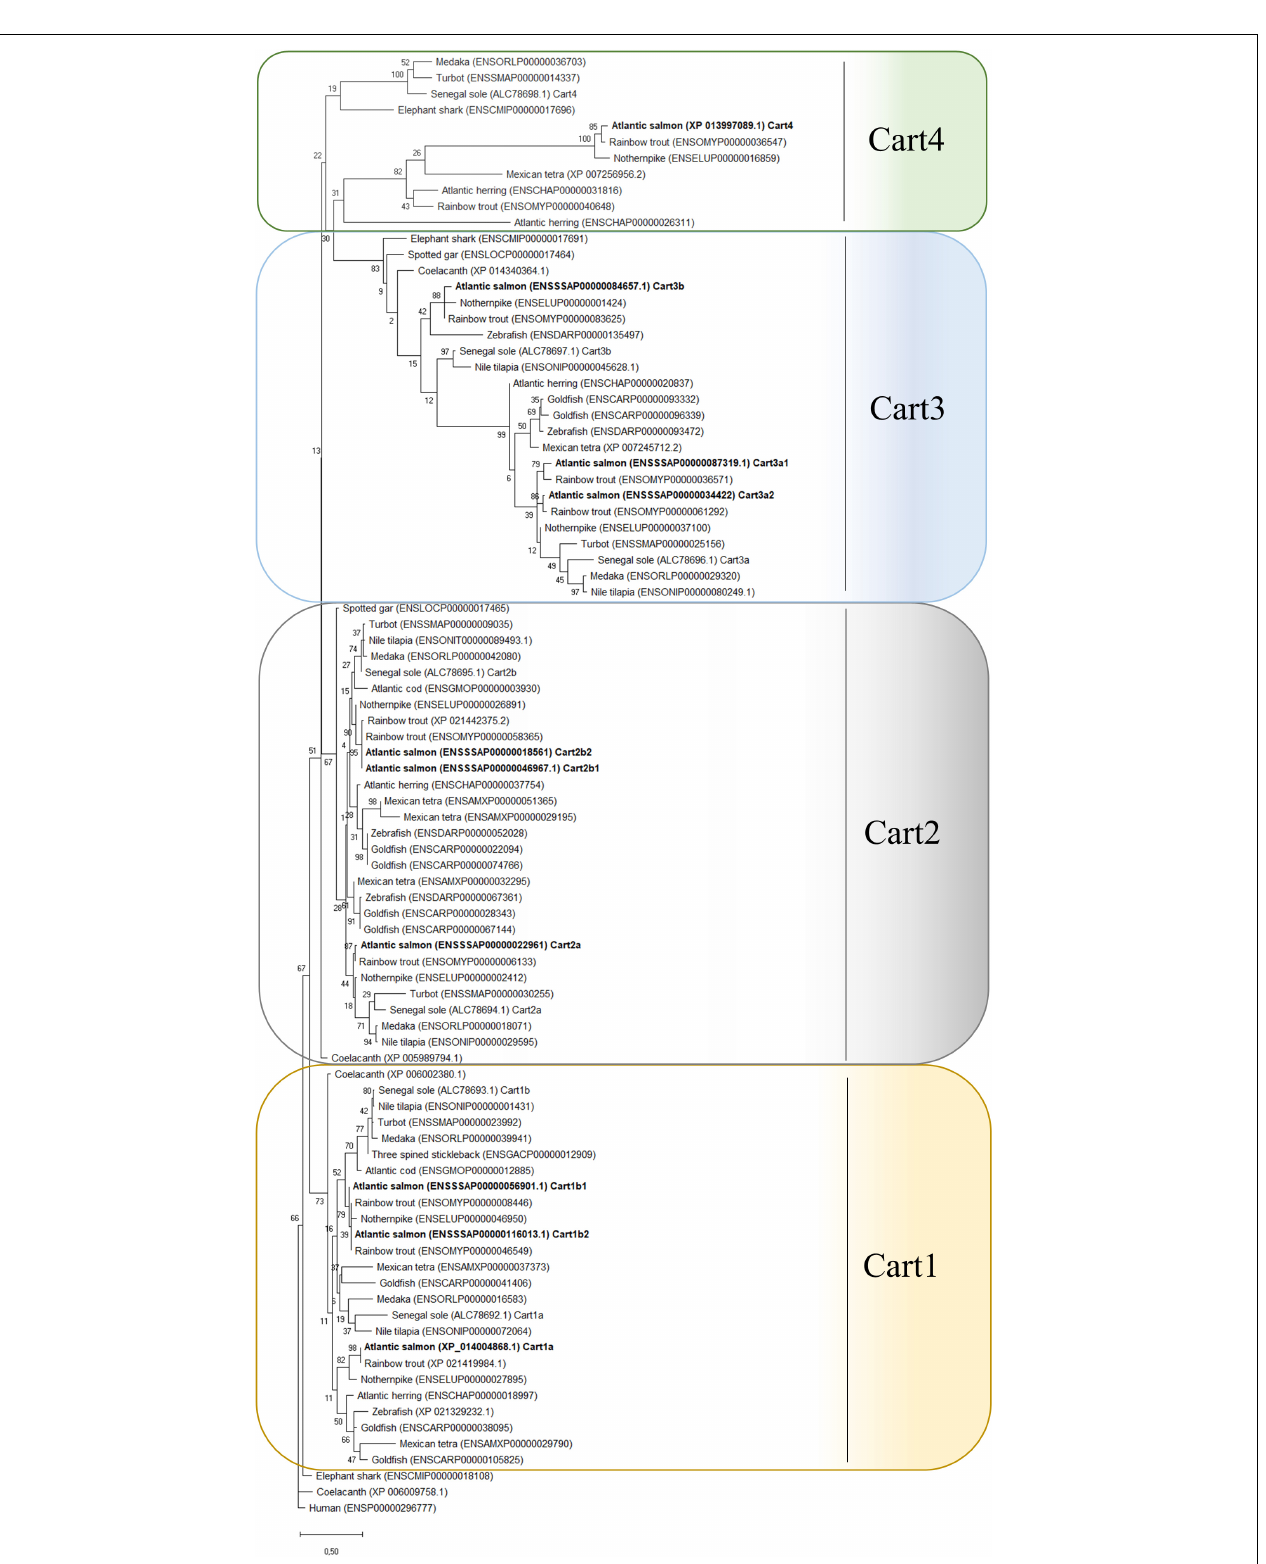
Frontiers in Marine Science |